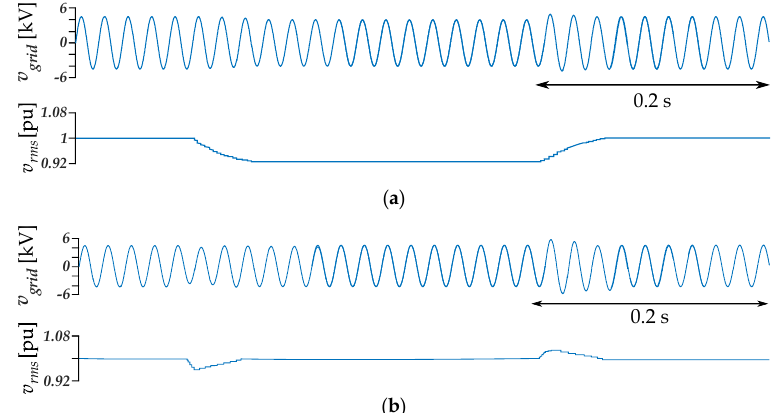
Figure 19. Simulated waveforms of voltage sag conditions. ( a ) Without static synchronous compensator ( STATCOM ). ( b ) With STATCOM